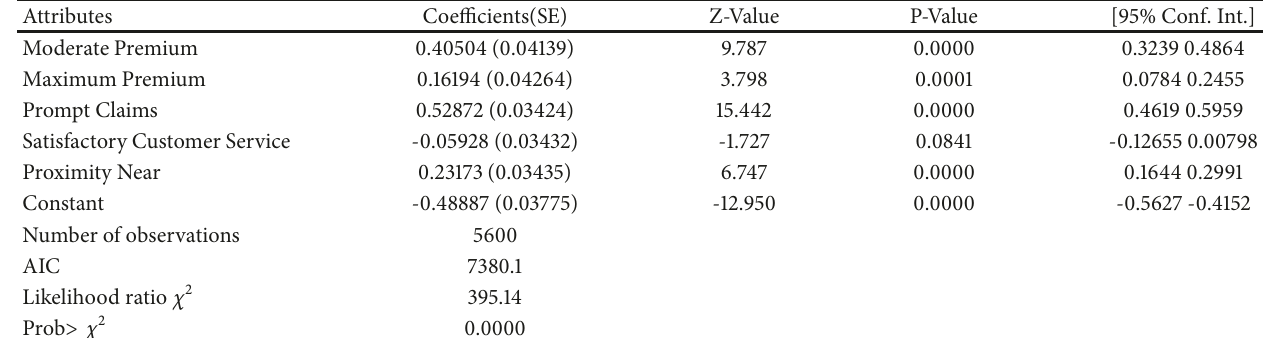
Table 4: Parameter estimates of full